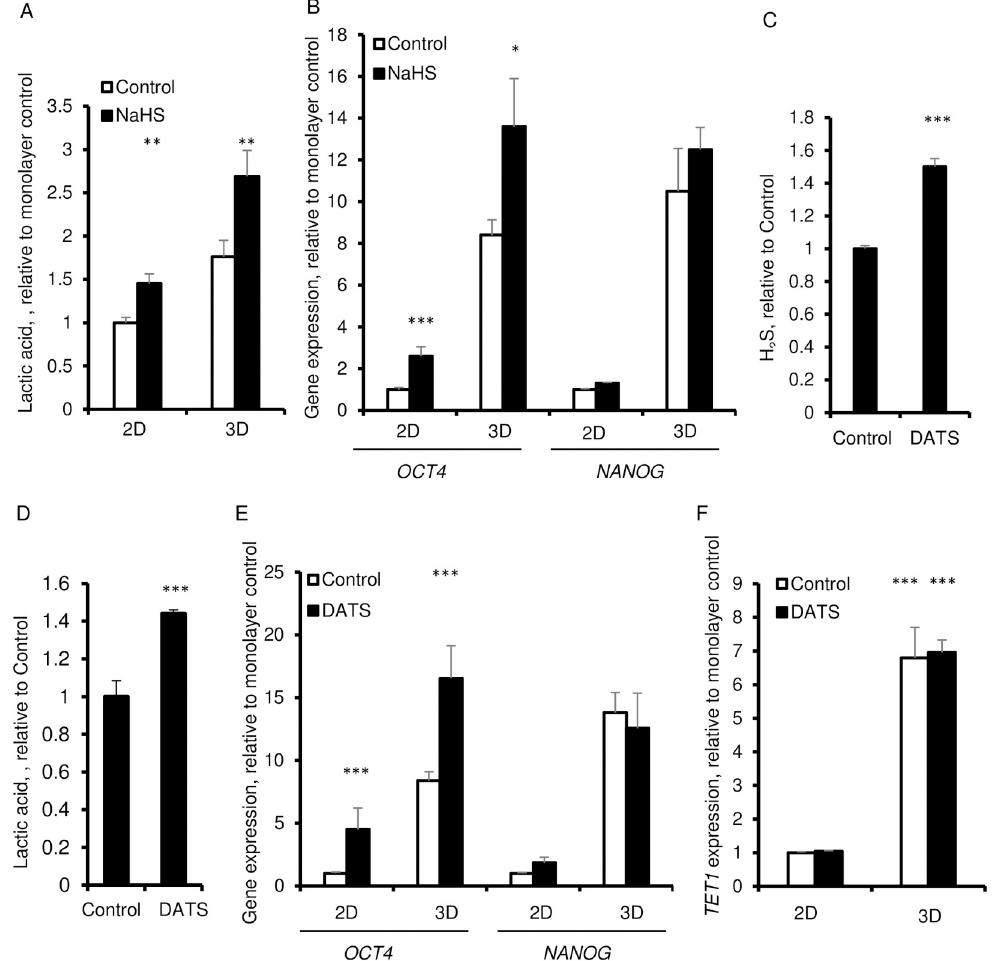
Fig 4. Effect of H 2 S donors, NaHS and DATS on lactic acid production and expression of OCT4 and NANOG in 3D spheroids. A. Extracellular lactic acid in presence of 50 μ M NaHS after 6 days. B. qPCR of OCT4 and NANOG in presence of 100 μ M NaHS for 6 days. C-G. HDFs were cultured for 6 days in in 2D and 3D in the absence and the presence of 50 μ M DATS. C. Extracellular H 2 S in presence of 50 μ M DATS after 6 days. D. Extracellular lactic acid in presence of 50 μ M DATS after 6 days. E. qPCR of OCT4 and NANOG . β -ACTIN was used as a housekeeping control. F. qPCR of TET1 . Data are presented as the mean ± SD from 3–6 independent experiments. β -ACTIN was used as a housekeeping control. Statistical significance is shown as � (p � 0.05), �� (p � 0.005), and ��� (p � 0.0005) in 3D as compared to 2D cultured